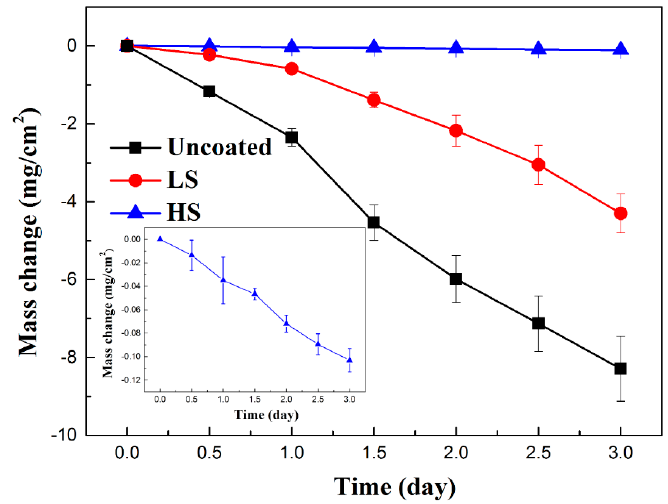
Figure 3. Corrosion kinetics of the uncoated, LS and HS samples corroded in the 0.5 M HCl solution at 30 °C. (inset is the magnified corrosion kinetics of the HS)